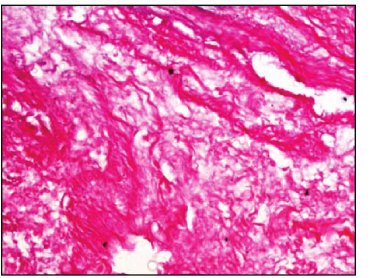
Figure 1: Microphotograph of native bovine gallbladder after delamination showing cellularity, loose muscular layer, and collagen fibers (H&E stain, 200x).